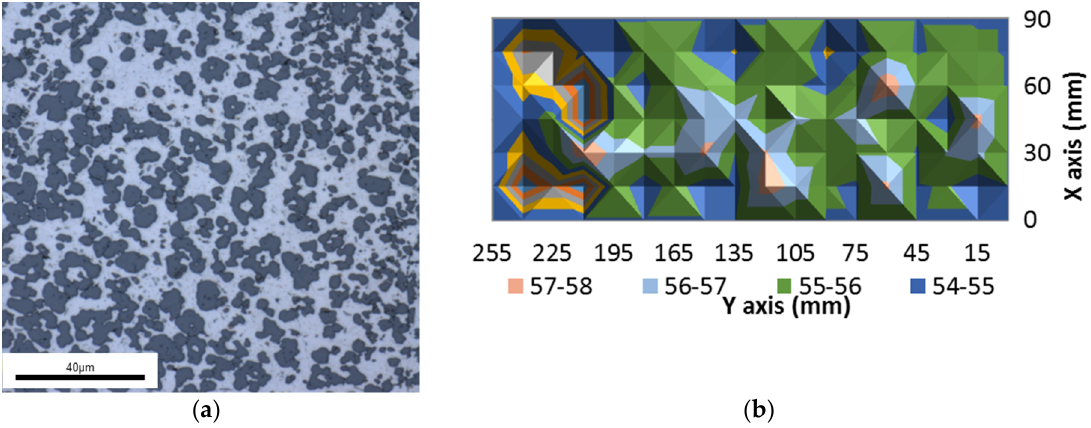
Figure 4. ( a ) Microstructure of hypereutectic RS Al–50%Si alloy and ( b ) HRB hardness distribution.